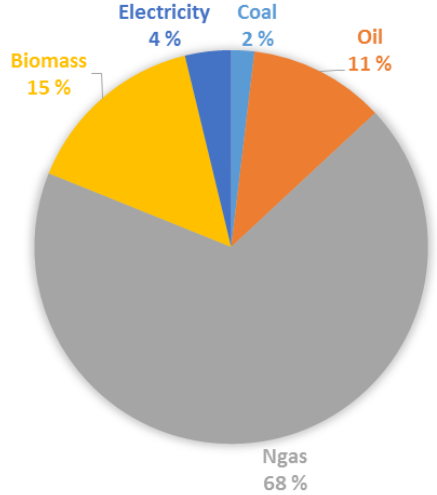
Figure 2. Fuel consumption for individual heating in Italy.